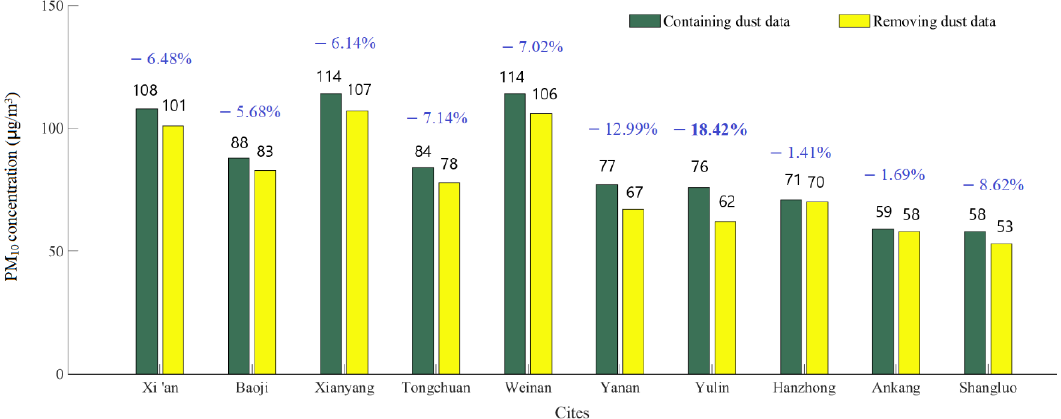
Figure 6. Comparison of PM 10 average concentrations containing and removing dust data in 10 cities from 2016 to 2022.